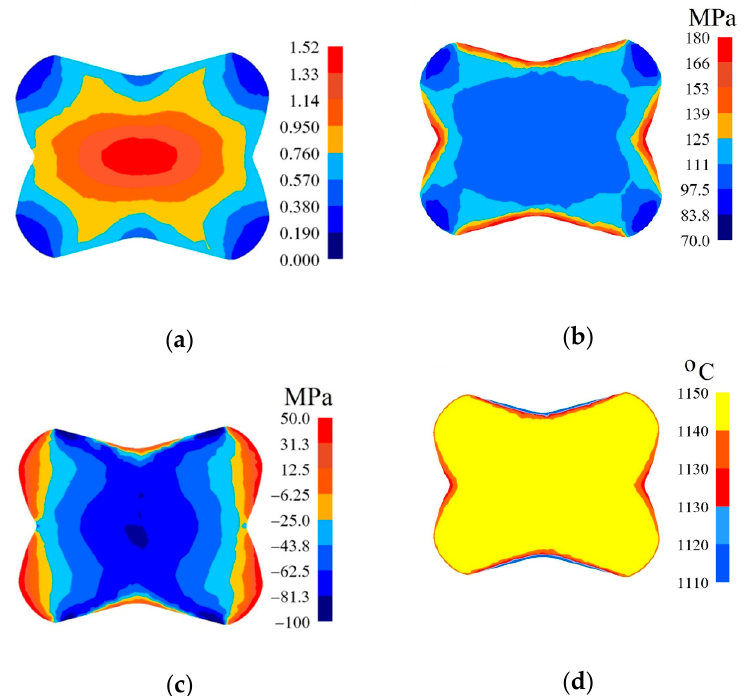
Figure 10. Distribution of the effective strain ( a ), effective stress ( b ), mean stresses ( c ), and temperature ( d ) on the cross- section of the workpiece in the course of forging in convex anvils after the second pass ( α c = 135°, ε c = 0.51).